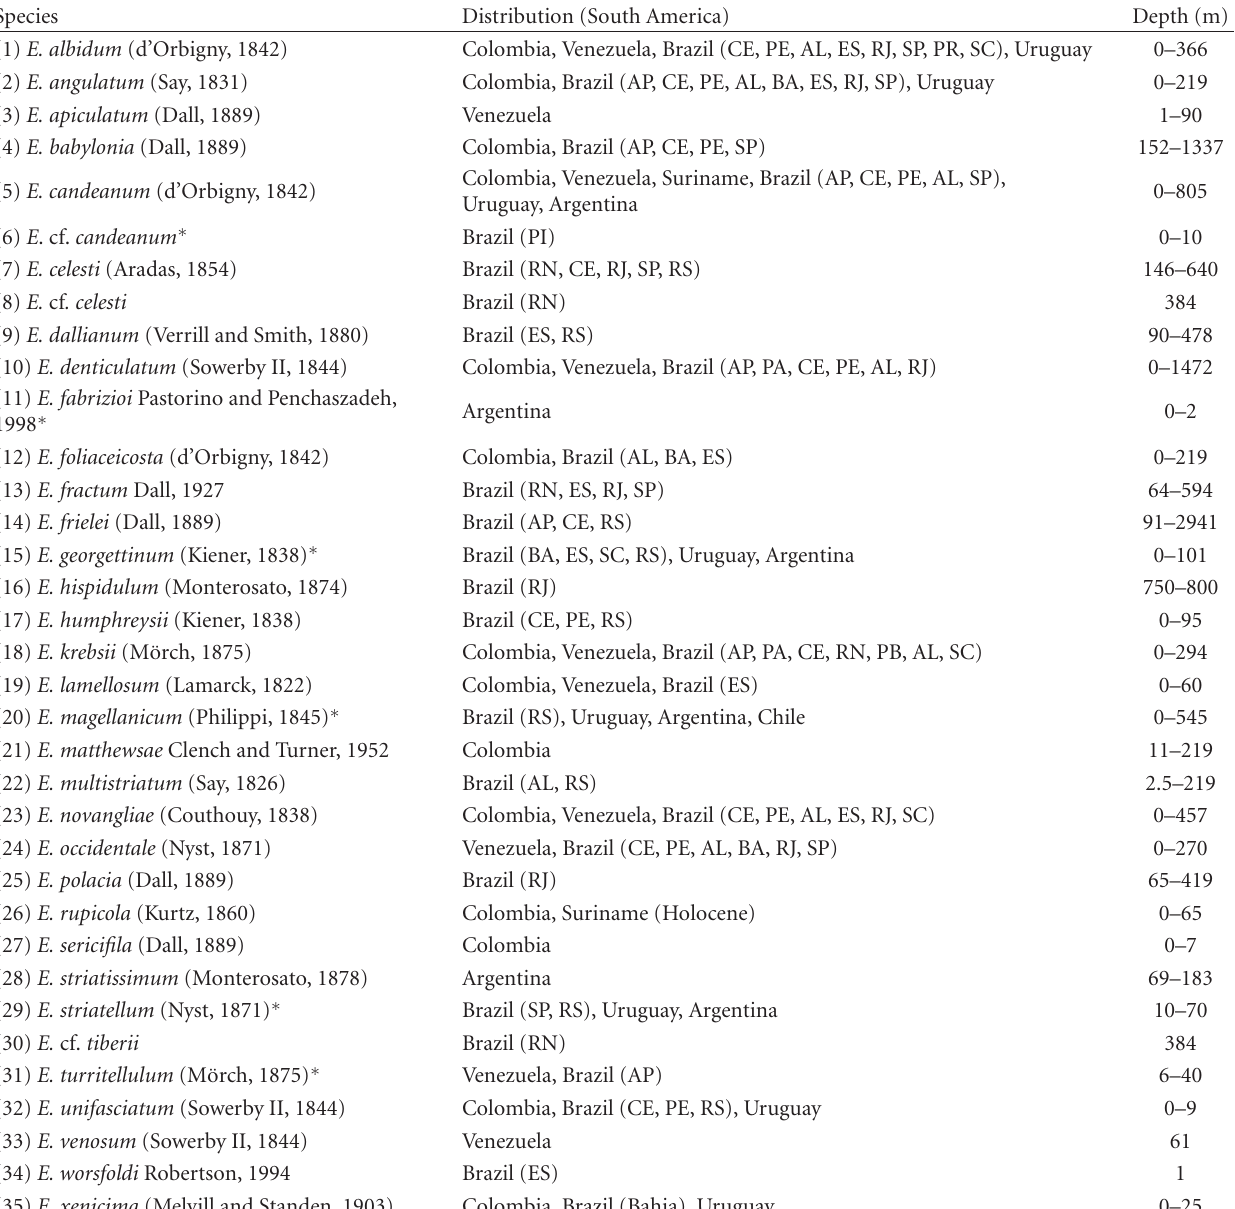
Table 1: Checklist of species of the genus Epitonium known for the Atlantic coast of South America with geographic and bathymetric